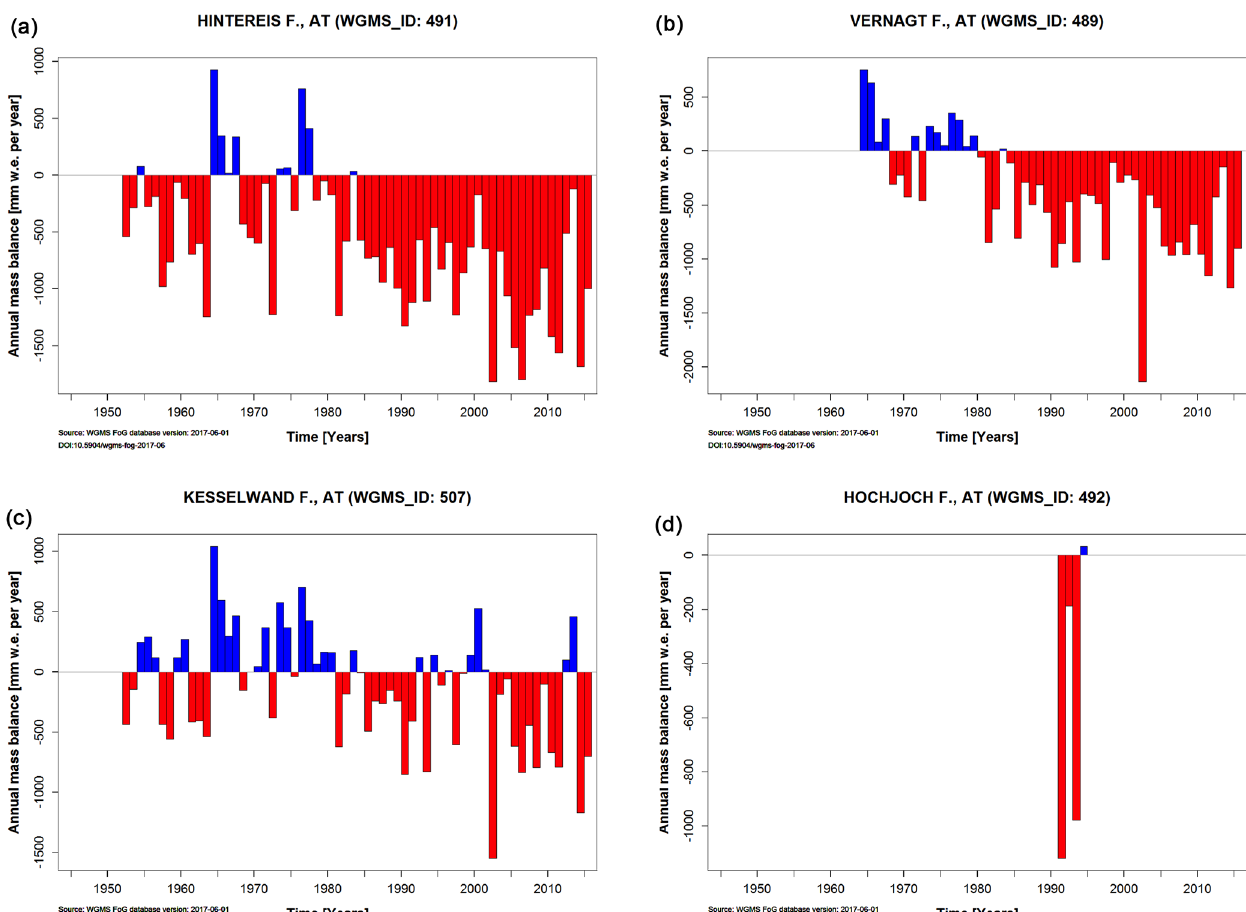
Figure 7. Annual mass balances for Hintereisferner (a) , Vernagtferner (b) , Kesselwandferner (c) and Hochjochferner (d) after the glaciolog- ical method using stake readings and snow pit data. From WGMS (http://wgms.ch, https://doi.org/10.5904/wgms-fog-2017-06).